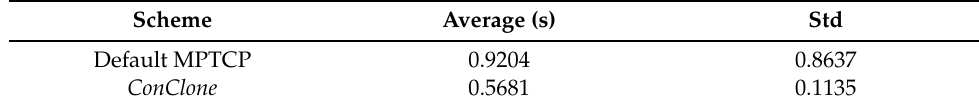
Table 2. Average and standard deviation of experiment with real devices.